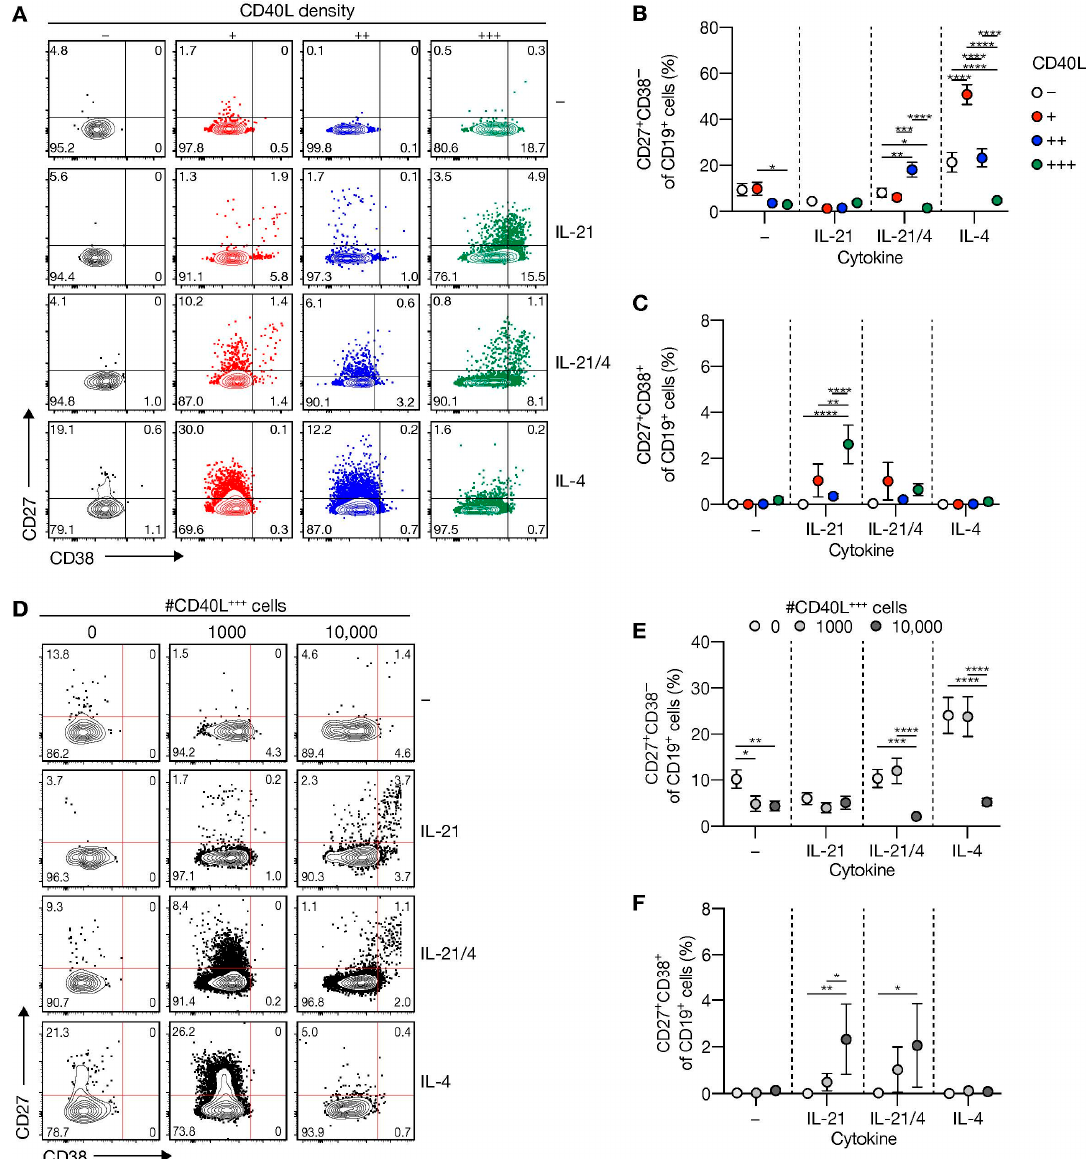
Figure 2. Level of CD40L expression and number of CD40L feeder cells regulates differentiation of human naive B-cell into CD27 + CD38 − B-cells and CD27 + CD38 + antibody-secreting cells. ( A ) Representative of FACS plot showing CD27 and CD38 expression among human naive B-cells cultured on CD40L-expressing 3T3 cells (as in Figure 1A) with or without IL-21 and/or IL-4 for 11 days. ( B , C ) The frequency of CD27 + CD38 − ( B ) and CD27 + CD38 + ( C ) populations were analyzed 11 days after culture on CD40L-expressing 3T3 cells and cytokines. ( D ) Representative plots of human naive B-cells cultured on 0/1000/10,000 CD40L +++ -expressing 3T3 cells (as in Figure 1A) supplemented to 10,000 with WT with or without IL-21 and/or IL-4 for 11 days. ( E,F ) The frequency of CD27 + CD38 − ( E ) and CD27 + CD38 + ( F ) cells 11 days after culture on different numbers of CD40L +++ -expressing 3T3 cells and cytokines. Data are shown as the mean ± SEM. (n = 6 ( A – C ) and n = 7 ( D – F ) independent experiments). Single experiments were conducted in triplicate. Data were analyzed by a two-way ANOVA followed by Tukey’s multiple comparison test. * P ≤ 0.05, ** P ≤ 0.01, *** P ≤ 0.001, **** P ≤ 0.0001.